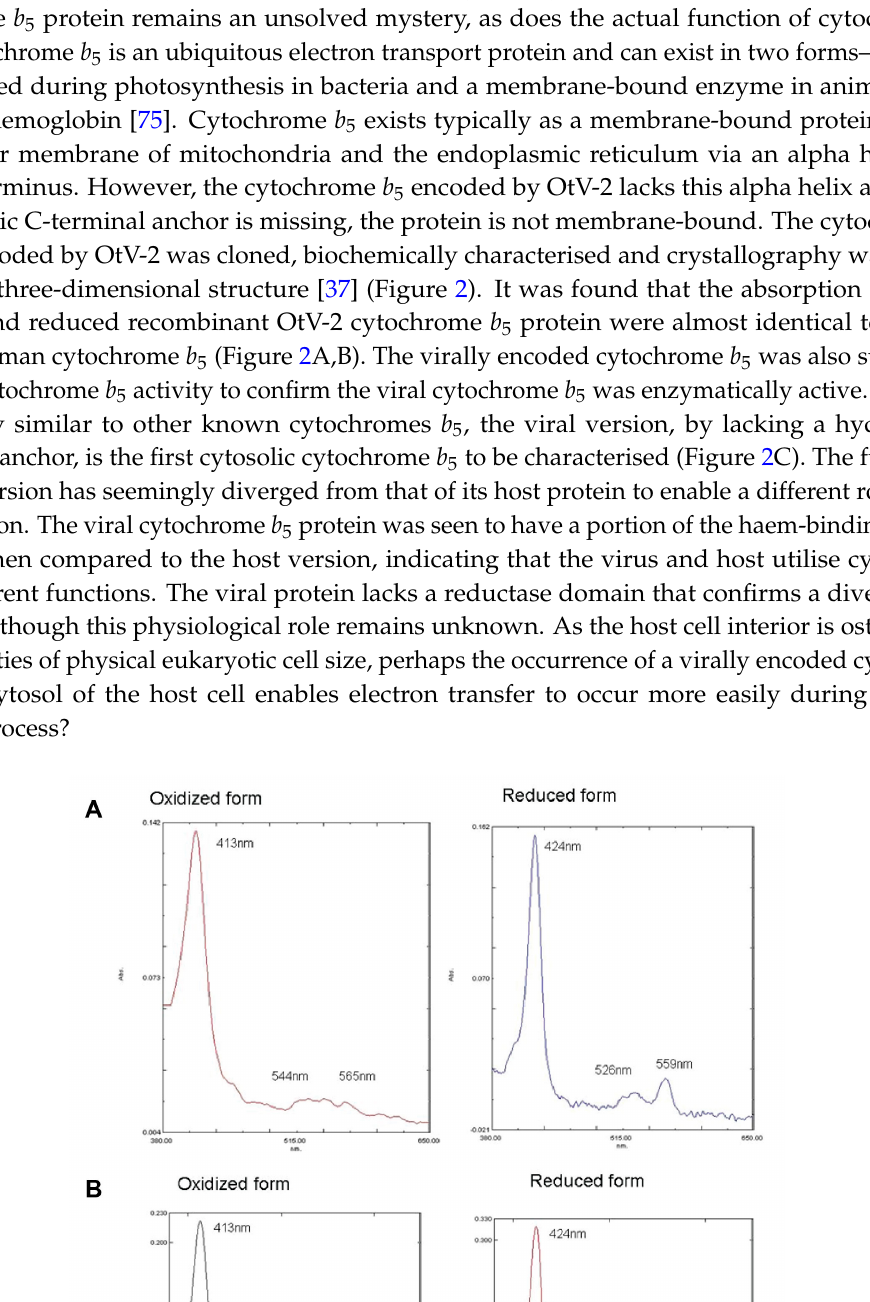
Figure 2. Characterisation of the OtV ‐ 2 virally encoded cytochrome b 5 protein. Absorbance spectra for oxidised and reduced forms of ( A ) human cytochrome b 5 protein and ( B ) OtV ‐ 2 viral cytochrome b 5 protein and ( C ) structural display of the OtV ‐ 2 protein as a ribbon diagram. Adapted from [37].